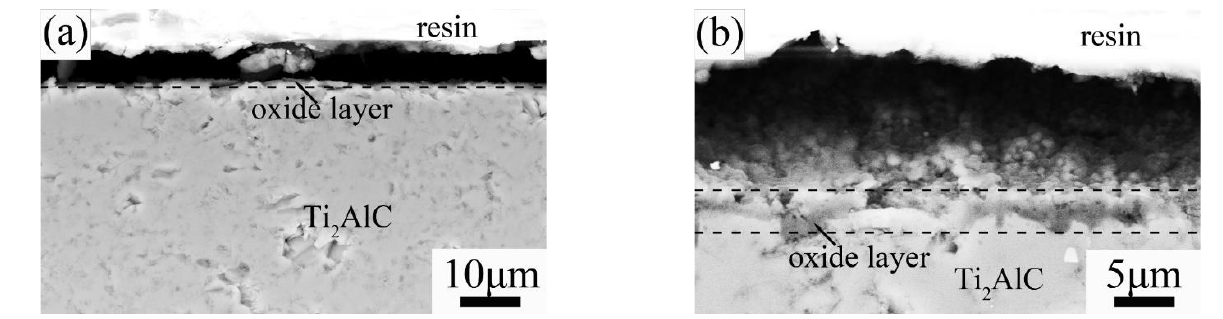
Figure 4. SEM micrographs of sample cross section of Ti 2 AlC ceramic quenched in air at different temperatures: ( a ) 920 °C and ( b ) 1150 °C. Table 2. Phase compositions of sample surface of Ti 2 AlC ceramic quenched in air at different tem- peratures.